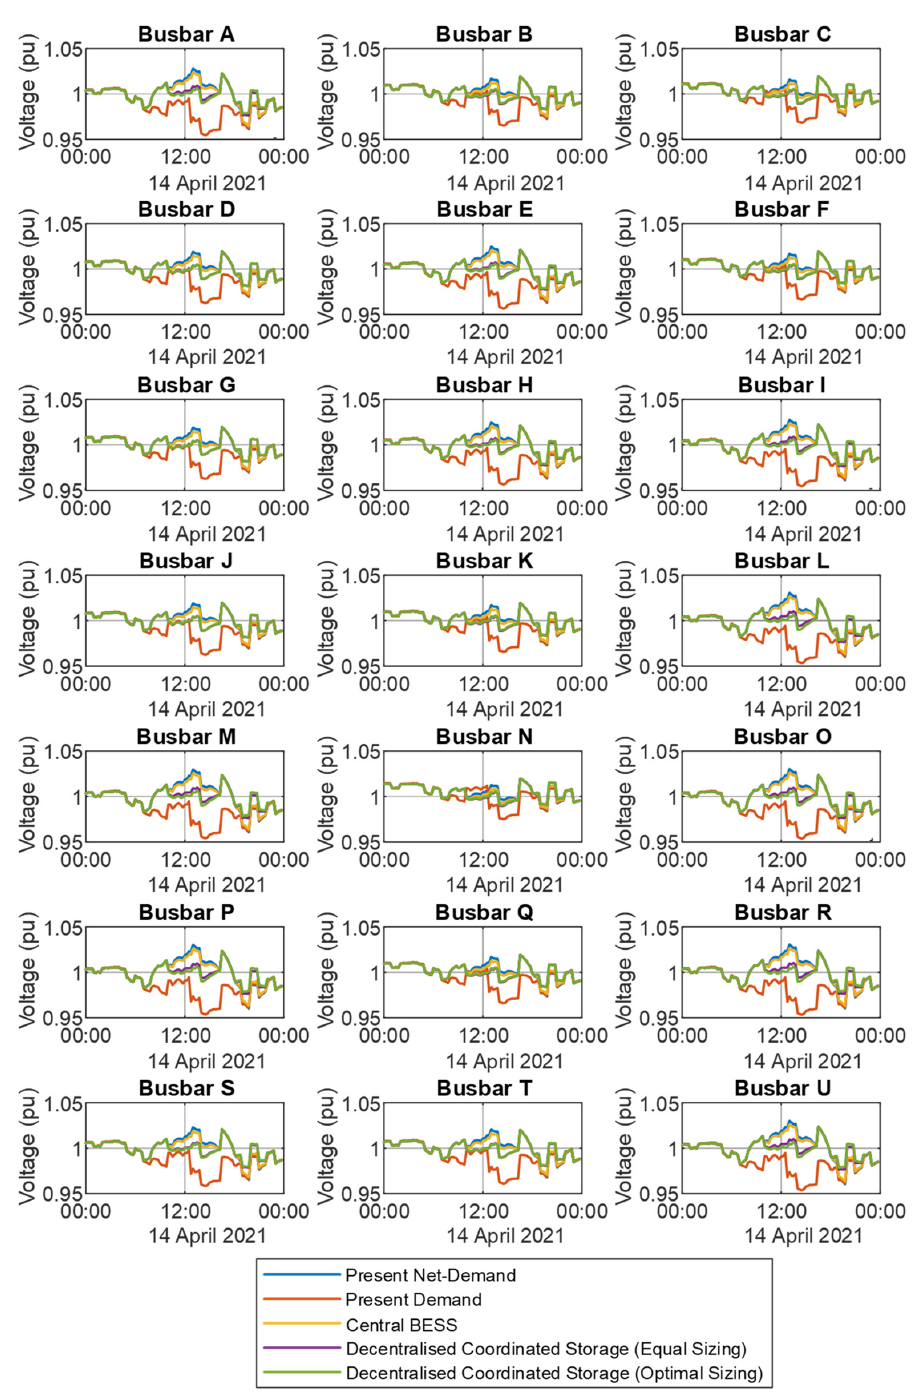
Figure 14. Simulated voltage profiles at the 11 kV side of the Xewkija DC transformer for all five case scenarios.